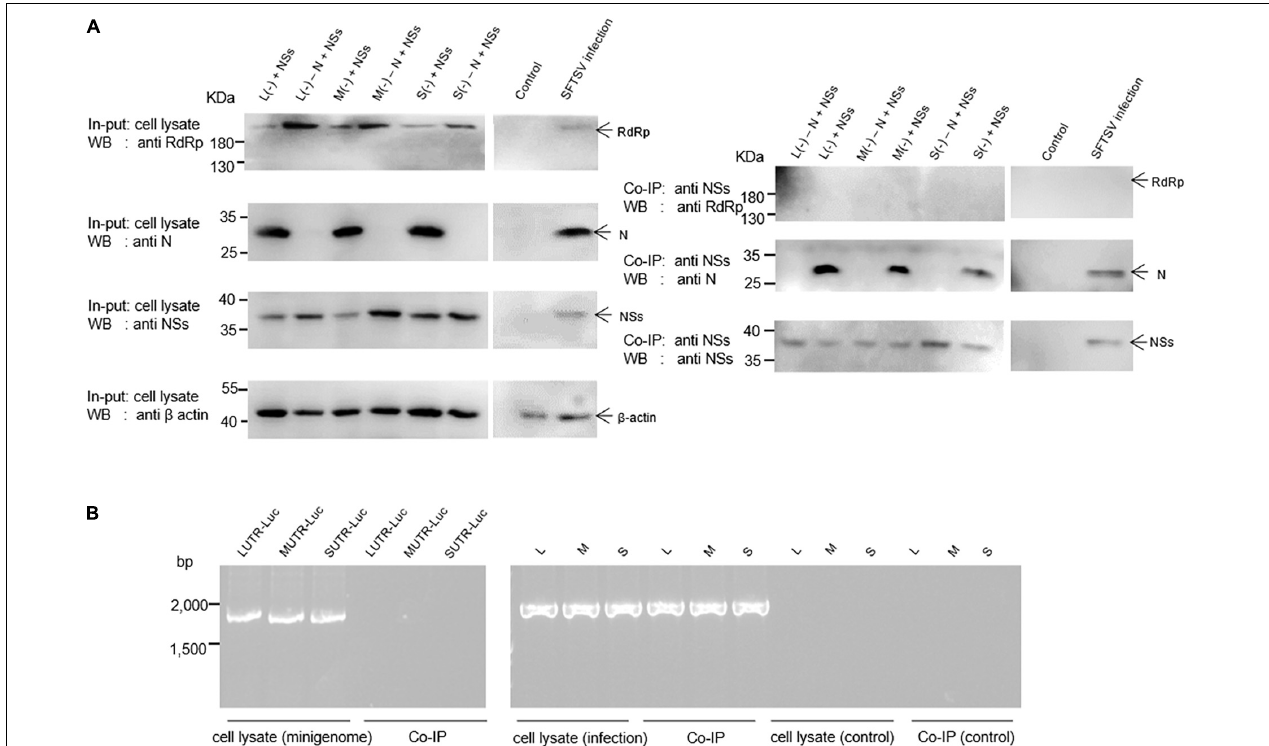
FIGURE 4 | SFTSV NSs are associated with N but not RdRp within the minigenome reporter systems and virus-infected cells. Co-IP assays and RT-PCR were used to identify the viral components interacting with NSs. Minigenome assays was carried out as previously described, and the amounts of expression plasmid and transcription plasmid were 0.5 µ g and 1.0 µ g, respectively. The amount of NSs expression plasmids was 1.0 µ g. Meanwhile, L (–), M (–), and S (–) that do not contain N expression plasmid were set up as negative controls, denoted as L (–)/M (–)/S (–) – N + NSs, respectively. At 48 hpt, cell lysates of L (–)-, M (–)-, and S (–)-transfected and virus-infected cells were subjected to Western blotting analysis ( A , left) and Co-IP ( A , right), respectively. Meanwhile, cell lysates and co-immunoprecipitates of L (–)-, M (–)-, and S (–)-transfected and virus-infected or control cells were all treated with TRIzol reagent to extract virus-like and viral RNA, which were then subjected to RT-PCR analysis (B)